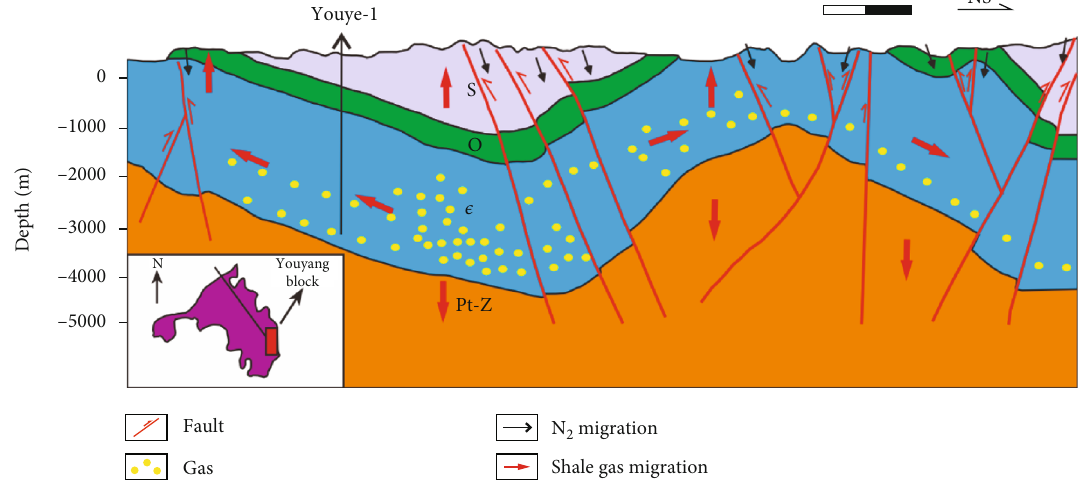
Figure 12: Geological section across Well Youye-1 in southeastern Chongqing area (modi fi ed from Wang et al.